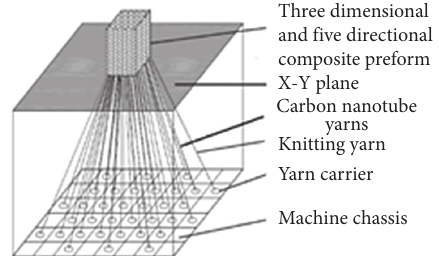
Figure 1: Schematic of four-step 3D braiding.